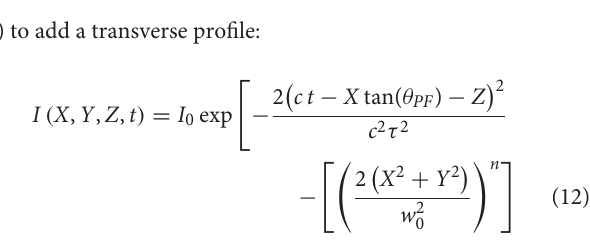
(1) to add a transverse profile: